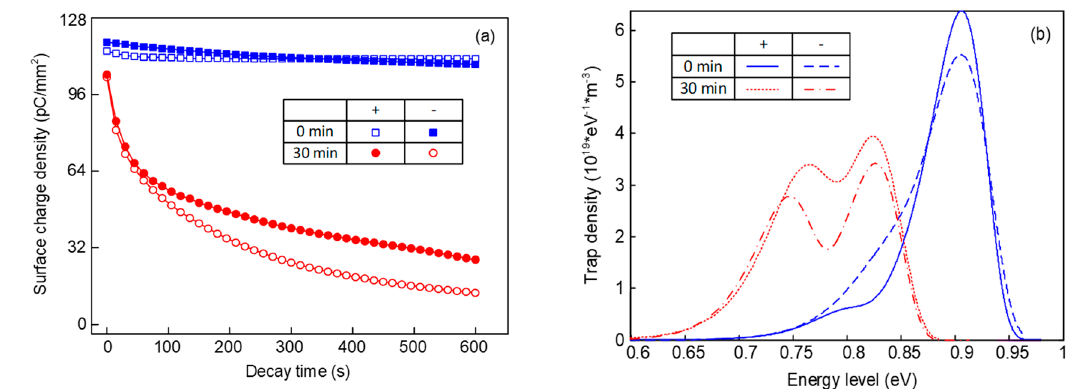
Figure 1. Surface potential decay process and trap distribution of epoxy resin before and after fluorination. ( a ) Relationship between the decay time and the surface charge density; ( b ) relationship between the energy level and the trap density of epoxy samples.